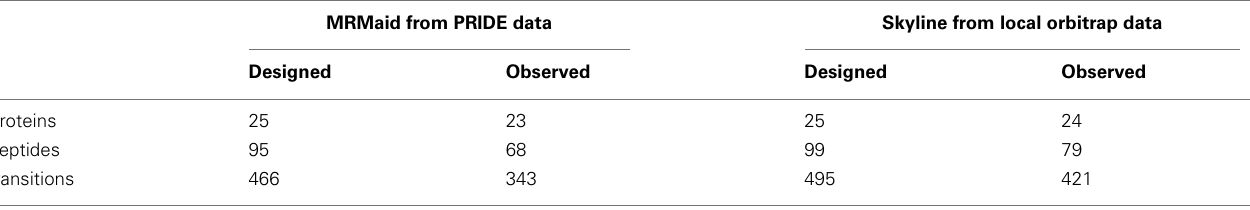
Table 2 | Numbers of designed and observed transitions from MRMaid and